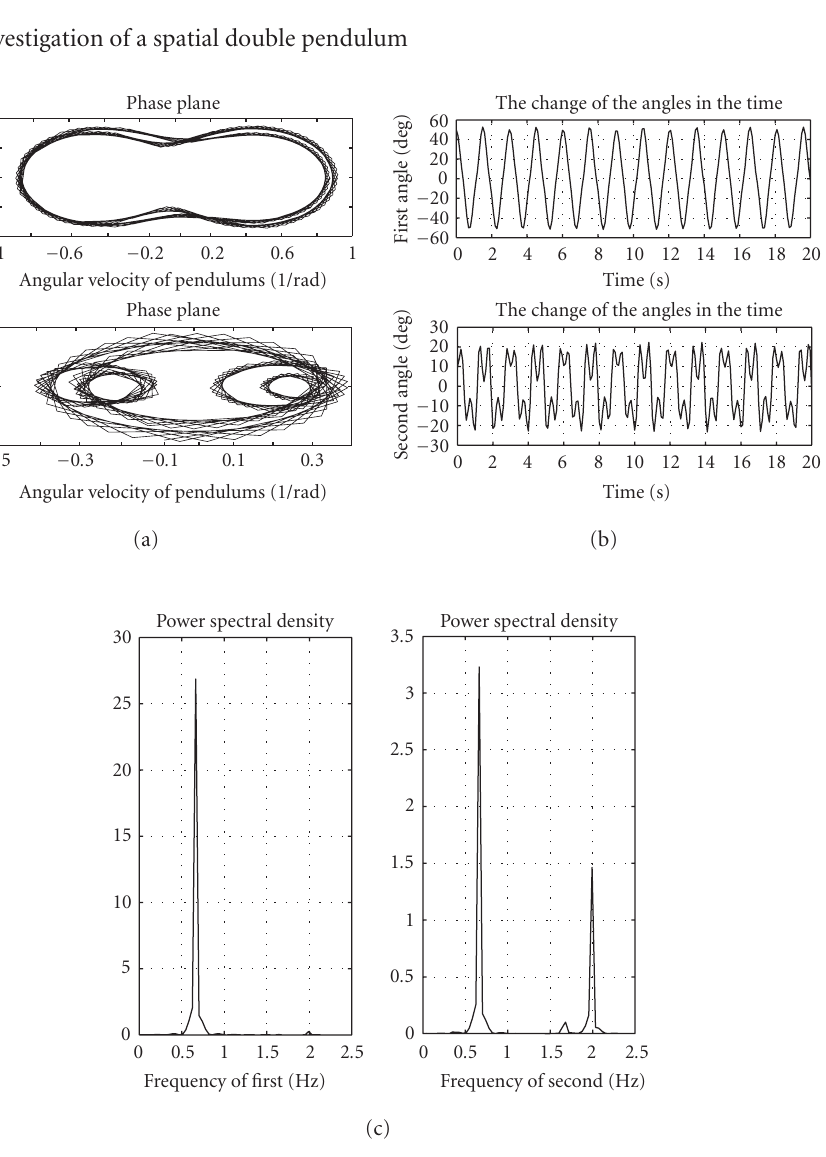
Figure 3.1. (a) “Phase portraits” for the two pendulums; (b) swinging angles ϕ 1 ( t ) and ϕ 2 ( t ); (c) oscillation spectrum distributions for the two pendulums. Parameters are m 1 = m 2 = 1 . 57 kg, L 1 = L 2 = 0 . 3 m, Ψ = 0 ◦ . Initial conditions are ϕ 1 = 50 ◦ , ϕ 2 = 0 ◦